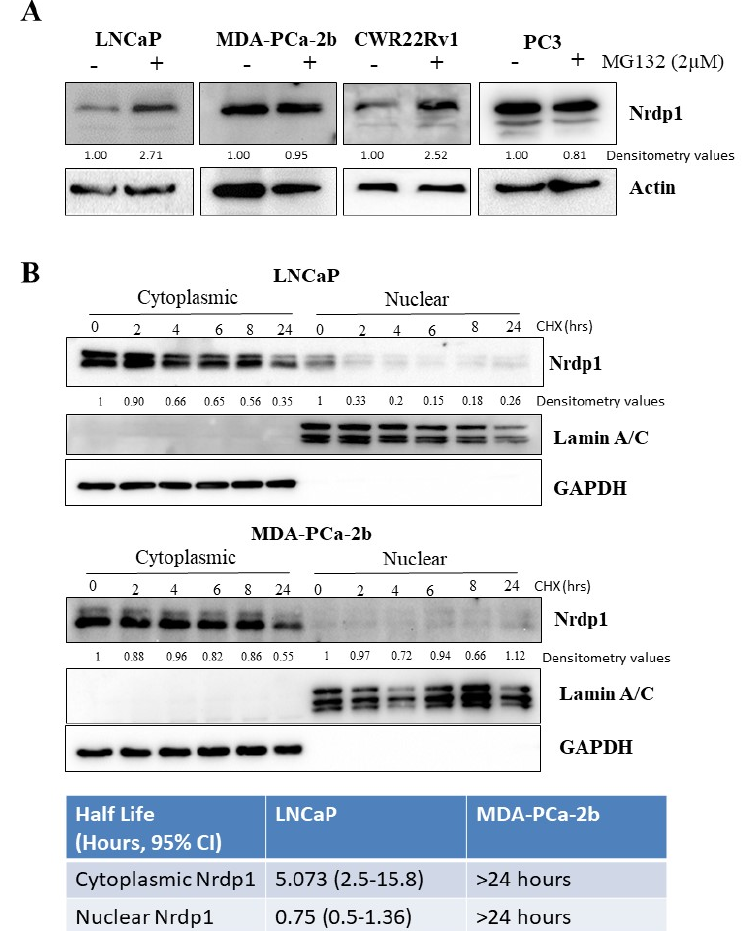
Figure 8. Nuclear NRDP1 levels are regulated by proteasomal degradation in some but not all prostate cancer cells. Treat- ment of LNCaP, MDA-Pca-2b, and CWR22Rv1 cells with a proteasome inhibitor, MG-132 (2 µM, 16 h), resulted in accu- mulation of NRDP1 indicating that proteasomal degradation can regulate NRDP1 levels in these cell lines ( A ); 1.85, 1.76, and 2.52-fold increases in NRDP1 levels following MG-132 treatment (normalized to actin). Treatment with cycloheximide, which inhibits protein synthesis (100 µg/mL), over a 24-h period followed by subcellular fractionation and western anal- yses revealed that nuclear NRDP1 has a much shorter half-life compared to cytoplasmic NRDP1 in LNCaP cells ( B ); the nuclear half-life of NRDP1 was approximately 0.75 h compared to a cytoplasmic half-life of approximately 5 h. In MDA- Pca-2b, there was little or no decrease in nuclear or cytoplasmic NRDP1 levels over the 24-h time period indicating that stabilization is occurring. Detailed information about Western Blot can be found at supplementary materials.